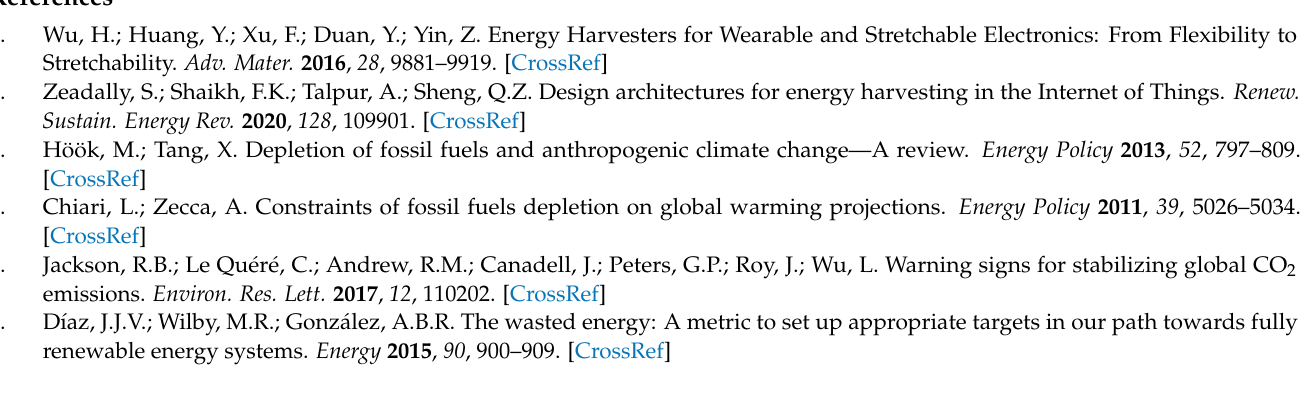
Figure S2: Schematics for flat and ‘U’ shaped L-TENG devices, Figure S3: Digital camera images of ‘U’ shaped L-TENG, Figure S4: Raw data of electrical outputs with the 2.5 cm:5 cm distance ratio, Figure S5: Output power density with the 2.5 cm:2.5 cm distance ratio, Figure S6: Digital camera images for before and after wrist bending, Figure S7: Unity program images for the gun shooting game, Figure S8: Current-force curve with the small L-TENG, Video S1: Video of illuminating LEDs with L-TENG, Video S2: Video of vibration sensing test with L-TENG, Video S3: Video of reloading trigger with L-TENG in the gun shooting game, Video S4: Video of detecting finger bending intensity with the small